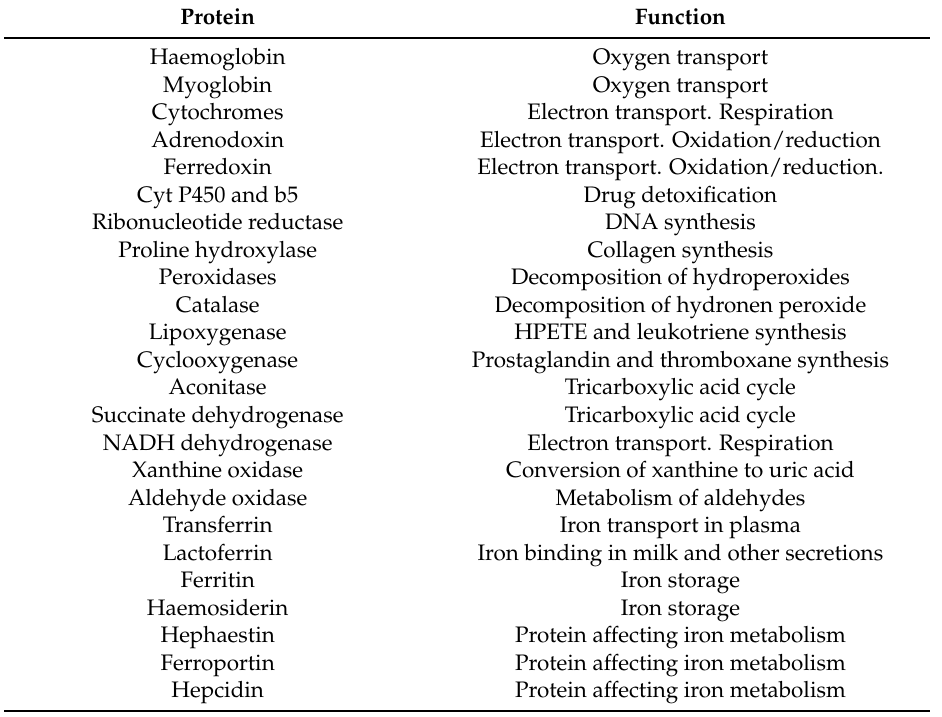
Table 3. Examples of iron-containing proteins and their function, which could be influenced or targeted by